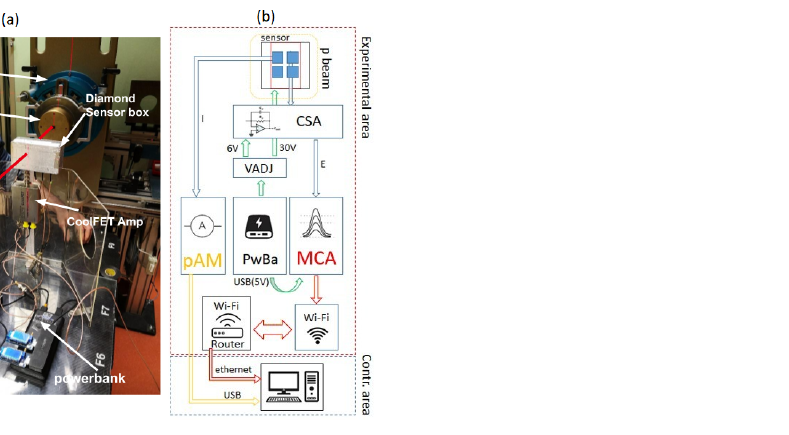
Figure 2. ( a ) A labelled photograph of the experimental set-up and ( b ) a schematic representation of the experimental set-up.